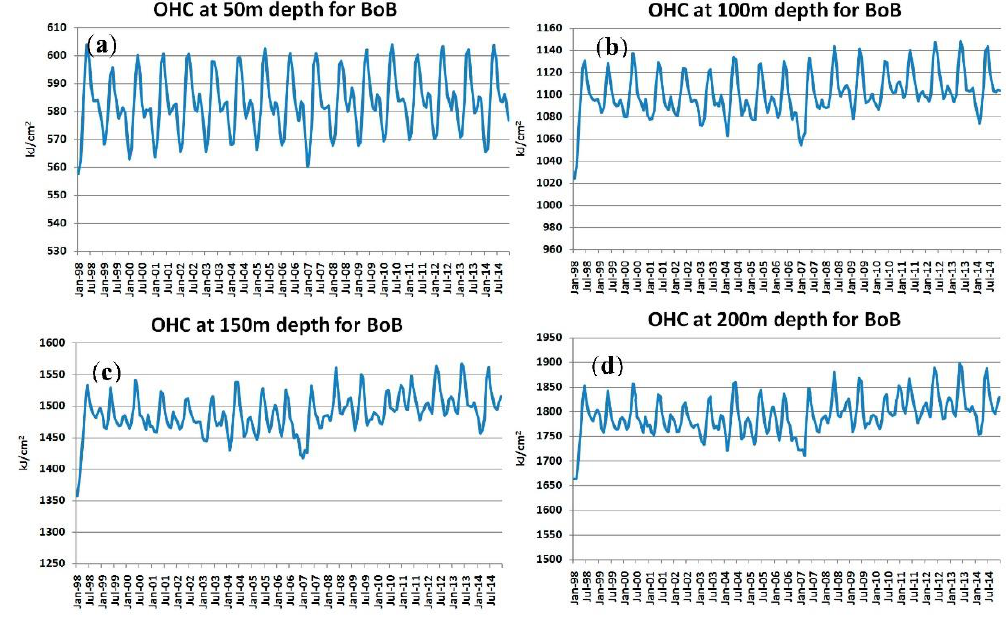
Figure 4. Time series of the Arabian Sea (AS) OHC from 1998 to 2014 for surface to ( a ) 50m, ( b ) 100m, ( c ) 150m, and ( d ) 200m depth.